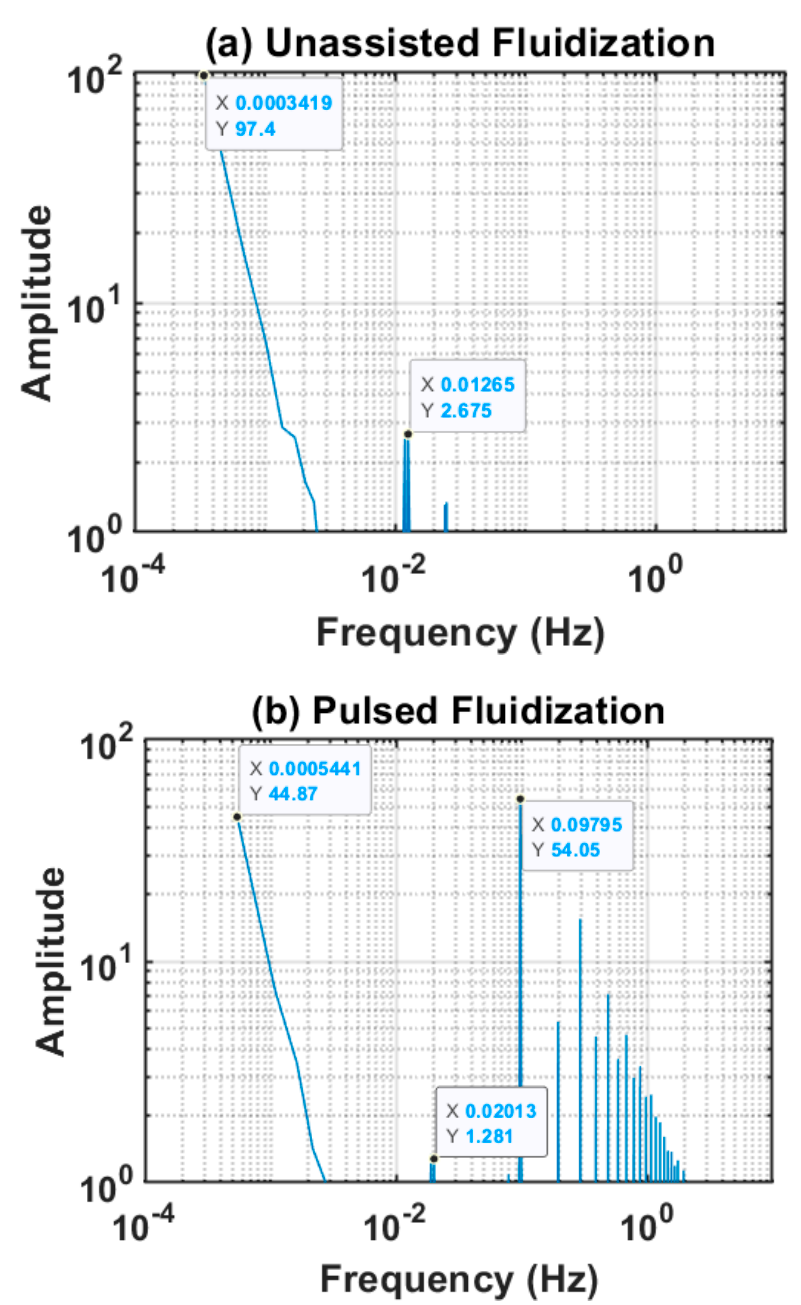
Figure 6. Frequency spectra of velocity. ( a ) unassisted fluidization; ( b ) pulsed fluidization.